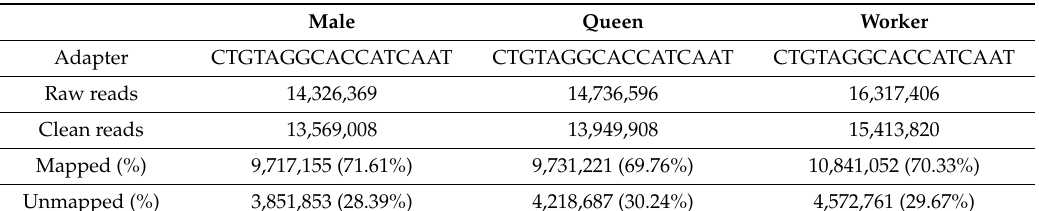
Table 2. Classification of small RNAs belonging to di ff erent categories that are expressed in the three castes of B. lantschouensis .